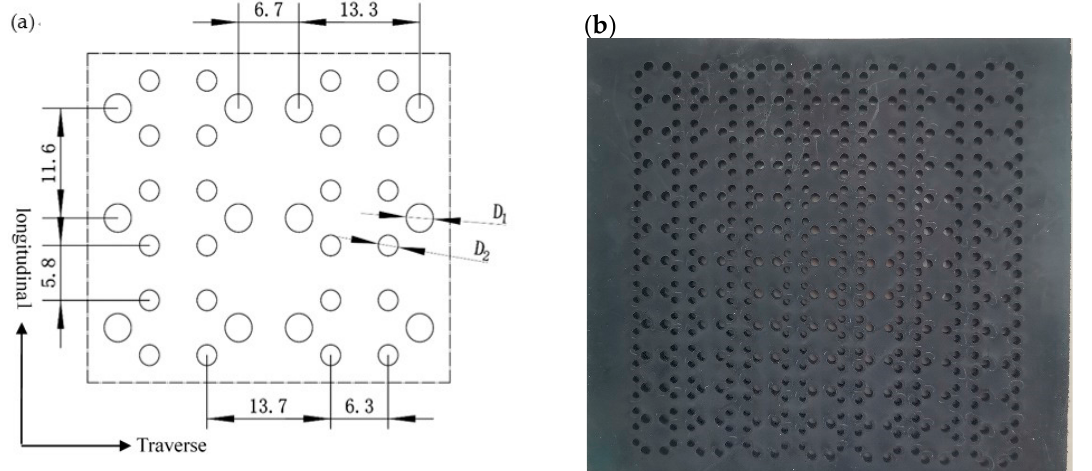
Figure 5. Hole arrangement of circular-circular pre-punched plate. ( a ) Plane diagram. ( b ) Physical drawing.